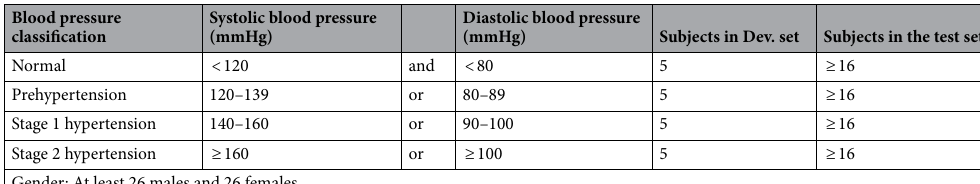
Table 1. Subject selection